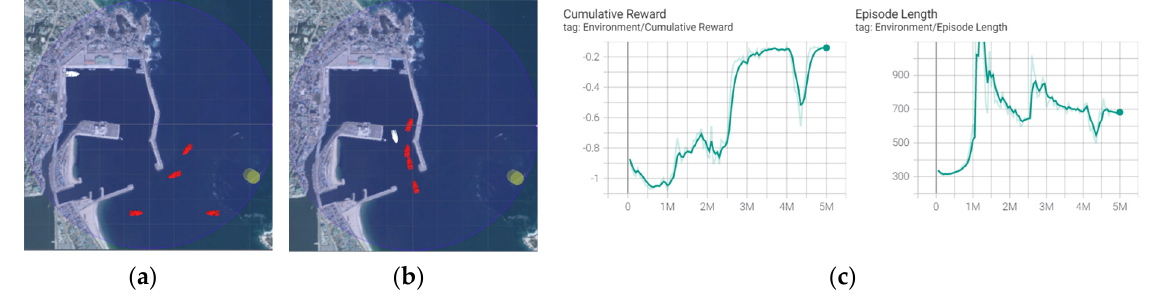
Figure 8. ( a ) Learning through two cases of neighboring ships entering harbors from two adjacent coastal areas. Cases are run through the case-based curriculum system. ( b ) As an example of operation in a normal port, incoming neighboring ships enter the port along the right path. ( c ) Convergence of learning from approximately three million steps, stabilizing after five million steps (approximately one learning scenario—no. of learning steps/700).